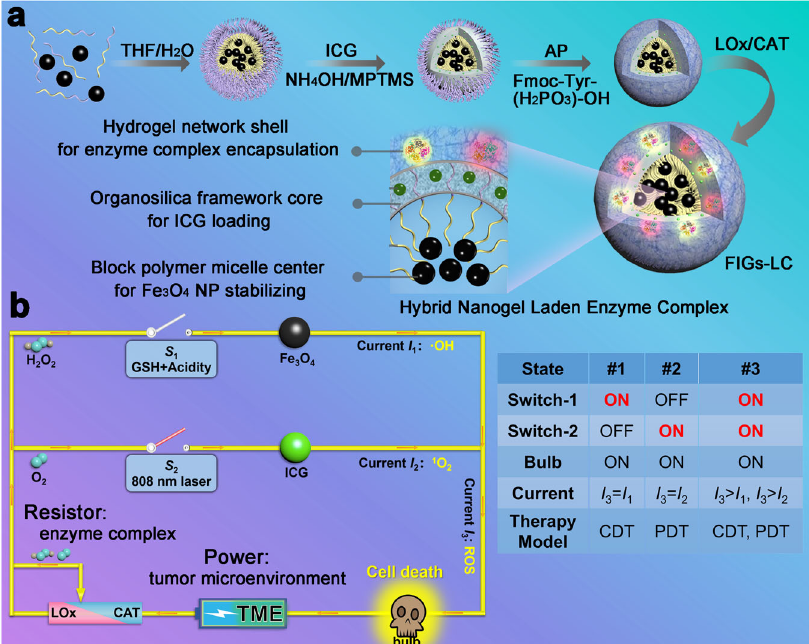
Fig. 1 Schematics of synthesis and therapeutic mechanism of FIGs-LC. a The synthetic procedures of FIGs-LC include: (1) self-assembly of Fe 3 O 4 NPs- encapsulated polystyrene- block -poly (acrylic acid) (PS- b -PAA) micelles (Fe 3 O 4 @PS- b -PAA) in selective solution; (2) the formation of indocyanine green (ICG)-loaded hybrid nanoparticles (Fe 3 O 4 @IHPs) by doping ICG and introducing organic silane 3-mercaptopropyltrimethoxysilane (MPTMS); (3) acid phosphatase (AP)-triggered hydrogel coating onto Fe 3 O 4 @IHPs, denoted with Fe 3 O 4 @IHPs@NanoGels (FIGs); (4) immobilization of lactate oxidase (LOx) and catalase (CAT) into FIGs, the fi nal particles are denoted by FIGs-LC. b Schematic circuit diagram for the peroxisome-inspired therapeutic mechanism of FIGs-LC based on the dual-enzyme-regulated ROS generation with GSH and NIR activation: the intratumoral lactate and H 2 O 2 are catalyzed by LOx and CAT (resistor regulation) to generate H 2 O 2 and O 2 , respectively. Then, H 2 O 2 is used to produce hydroxyl radicals (·OH, current I 1 ) in the presence of Fe 3 O 4 NPs within GSH-enriched acidic tumor microenvironment (Switch-1, S 1 ), leading to the cancer cell death (bulb on). In the reaction, the produced O 2 is converted into singlet oxygen ( 1 O 2 , current I 2 ) under the irradiation of an 808 nm laser (Switch-2, S 2 ), which can also cause signi fi cant cell death (bulb on). Both CDT and PDT can be executed independently and induce the death of cancer cells, as well be activated simultaneously ( S 1 and S 2 are connected) to achieve improved antitumor